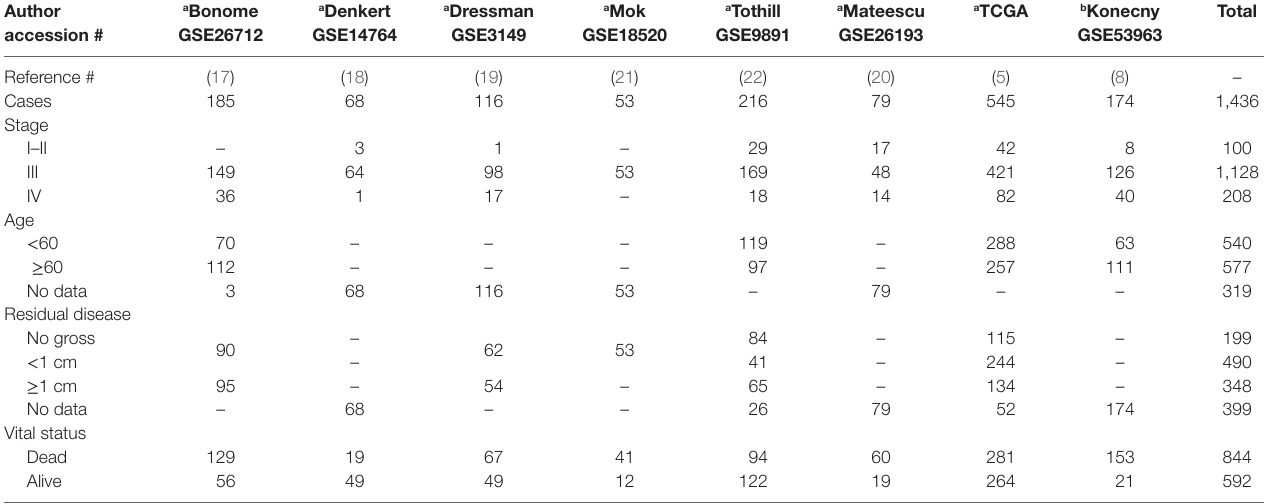
TaBle 1 | clinicopathologic characteristics of public transcript datasets